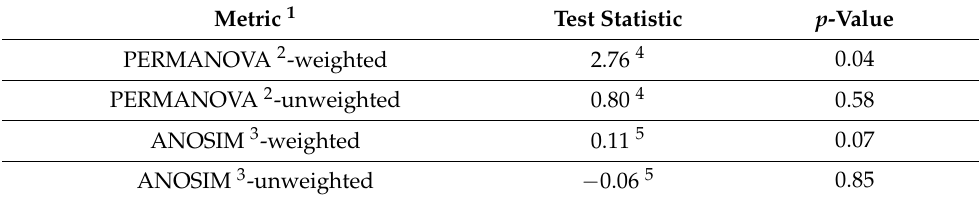
Figure 1. Principal coordinates analysis based on unweighted ( A ) and weighted ( B ) UniFrac distances of different levels of residual feed intake based on 9999 permutations. Low RFI = blue circle, High RFI = red square. Table 2. Beta-diversity analyses between high- and low-residual feed intake (RFI) steers.